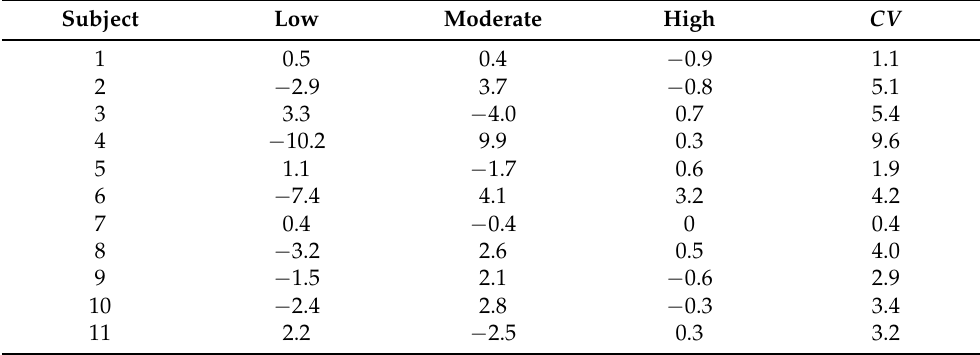
Table 5. Detection errors (in minute) per subject and per activity and corresponding coefficient of variation ( CV ) in % (“Rest” was merged into